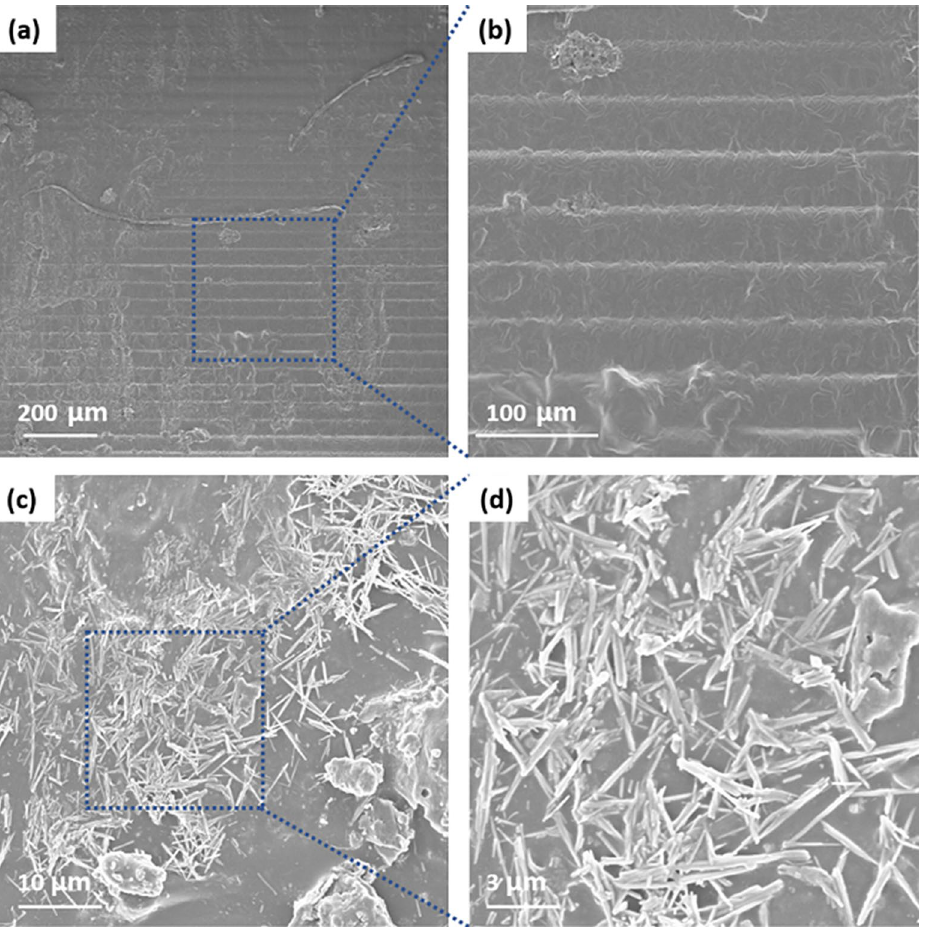
Figure 3. ( a ) Low and ( b ) high-magnification cross sectional FE-SEM images of cured resin. ( b ) low and ( c ) high-magnification cross sectional FE-SEM images of AS30 composite